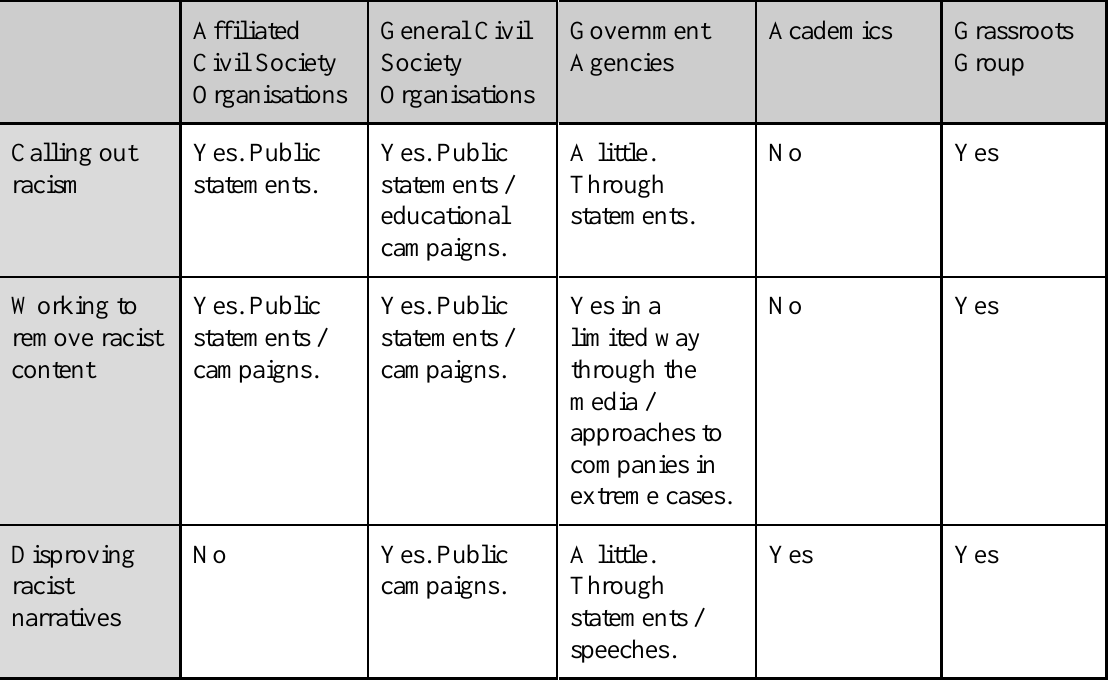
Table 1: Reactive modes of